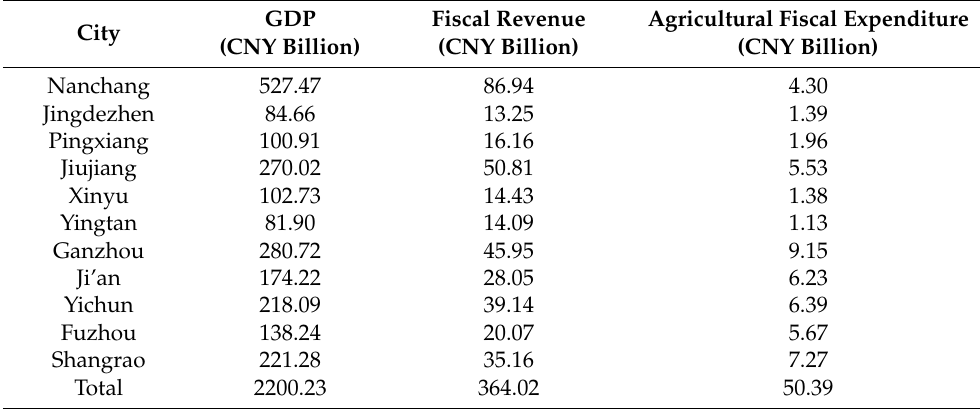
Table 4. The socio-economic situation in Jiangxi province.